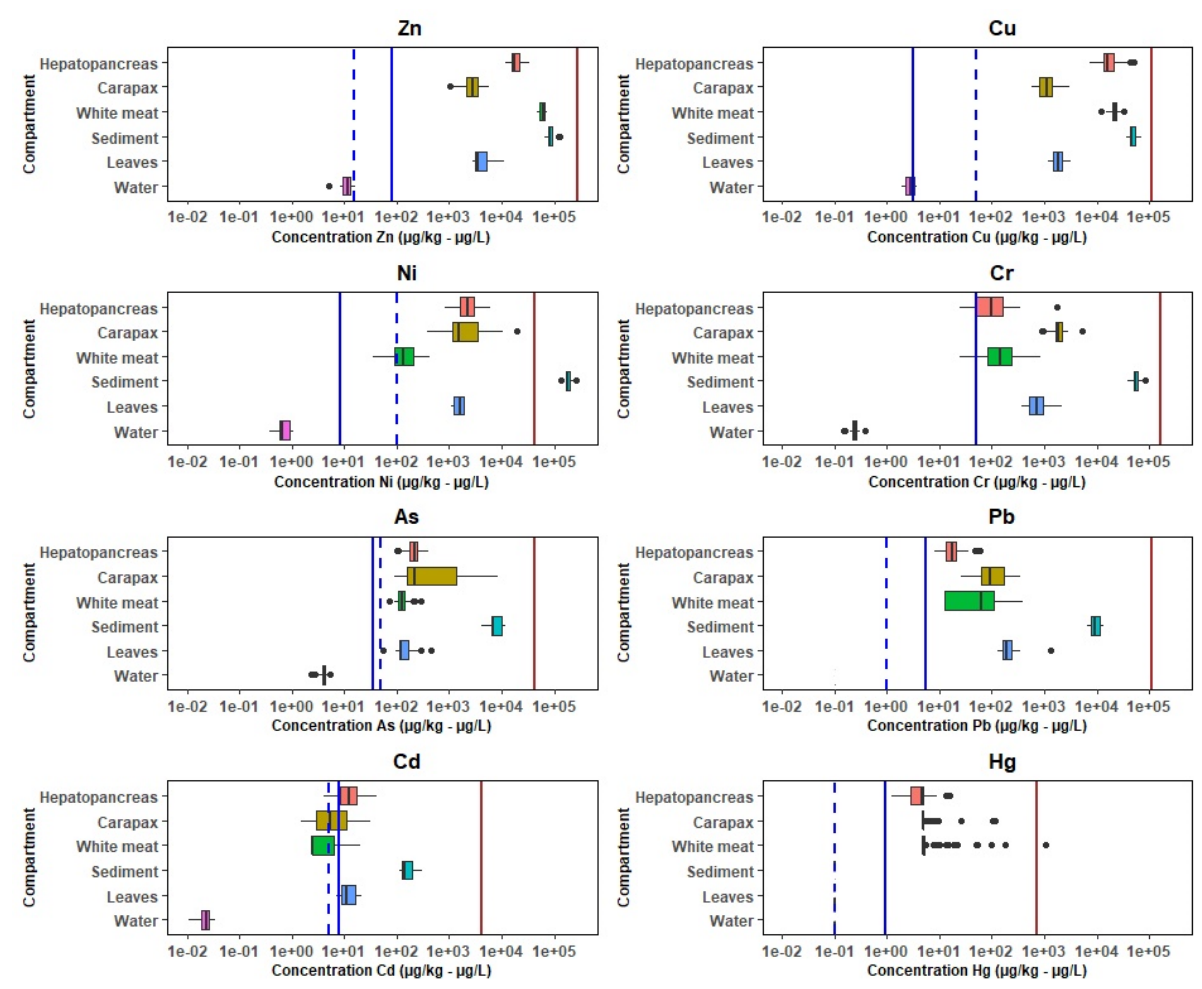
Figure 2. Boxplots with distribution of each metal in the compartments (µg/L for water compartment, and for others µg/g dry weight ). Indication of Probable Effect Level threshold for sediment quality (PEL) in brown, Criterion Continuous Concentration (CCC) for water quality in blue, and the national legislation threshold values for metals in water in dashed blue.